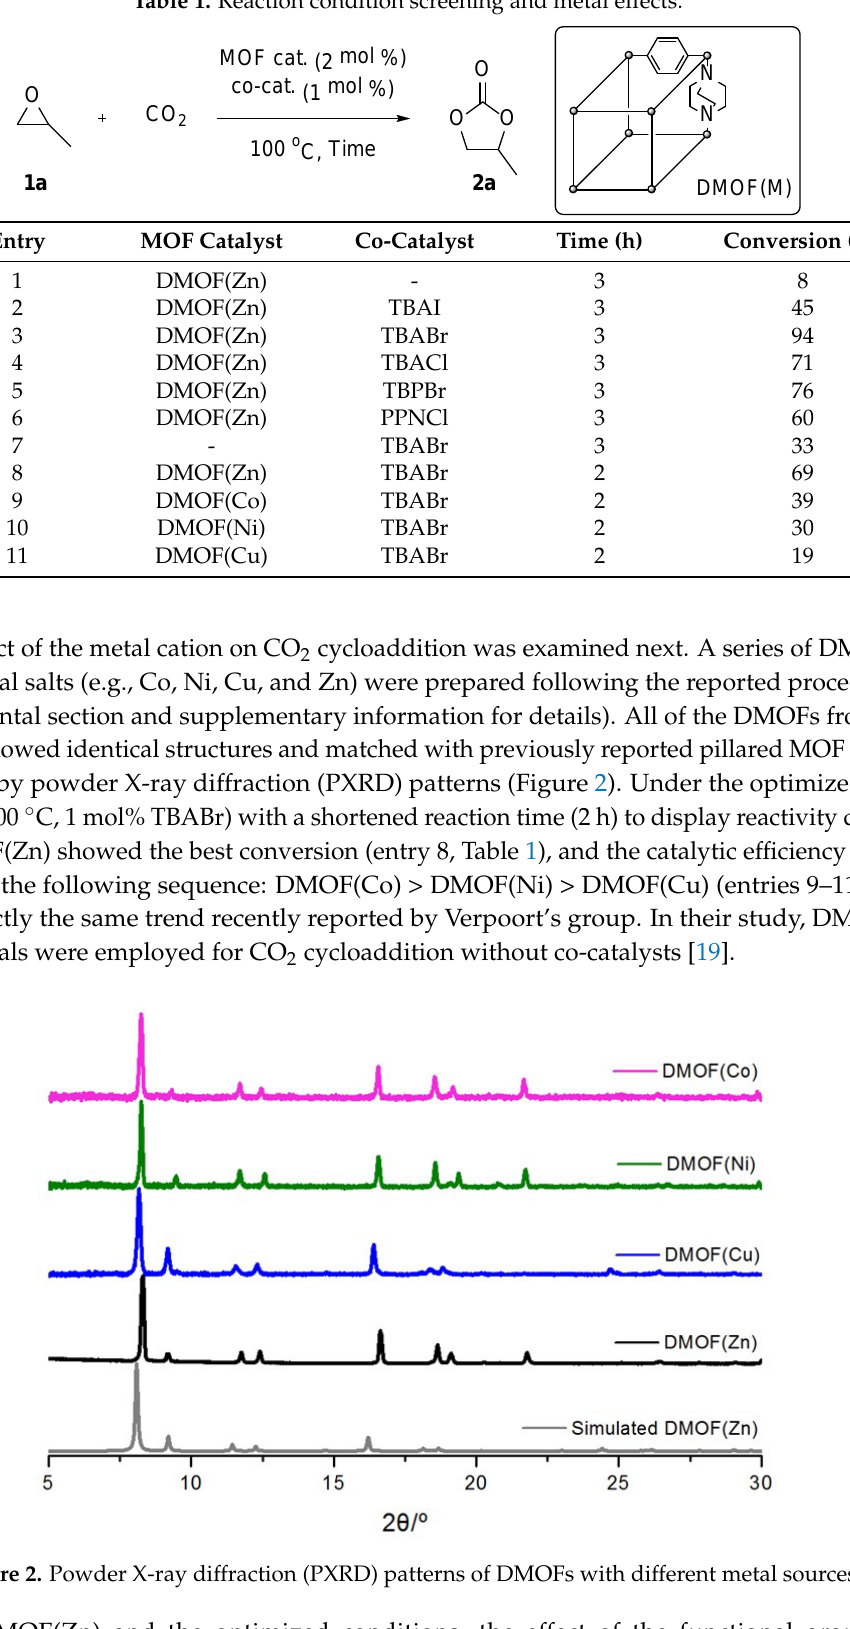
Table 1. Reaction condition screening and metal effects.